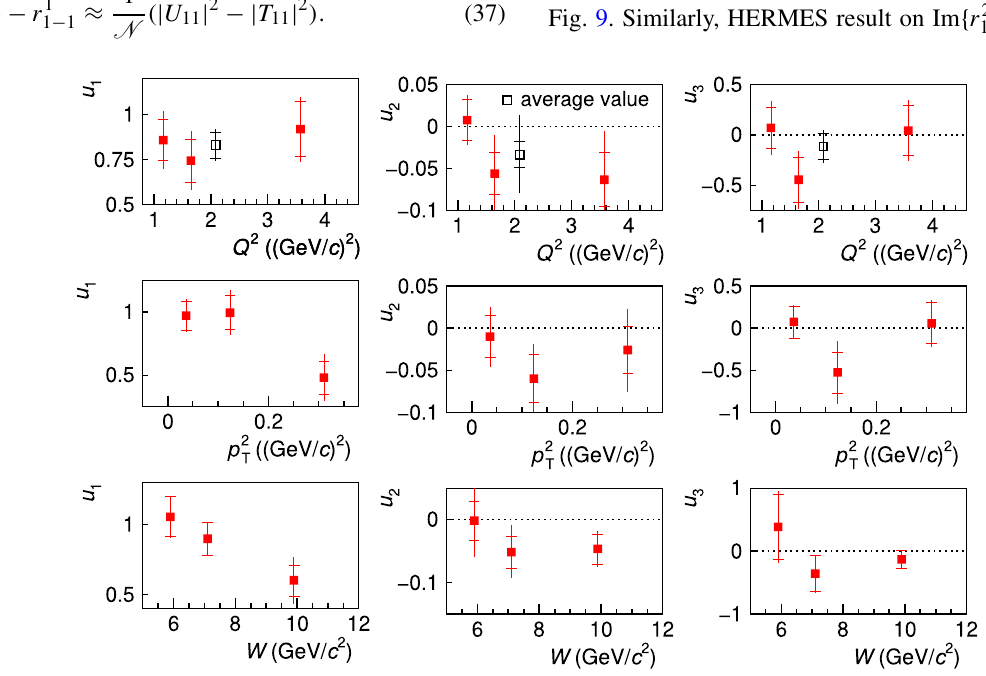
Fig. 9 Q 2 , p 2 , and W dependences of u 1 , u 2 , u 3 . The open symbols represent the values over the total kinematic region. Inner error bars represent T statistical uncertainties and outer ones statistical and systematic uncertainties added in